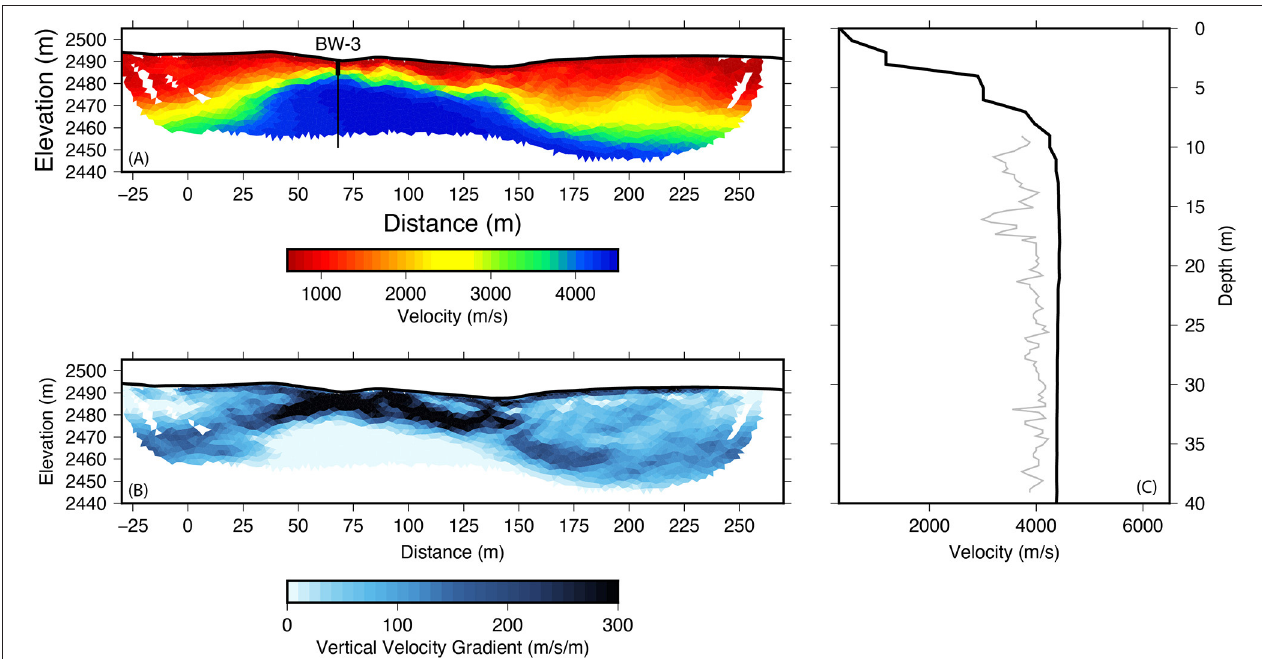
FIGURE 7 | Travel-time tomography results for L25. (A) Final P-wave velocity model estimated by travel-time tomography. Model fits and uncertainty are provided in the supplementary material ( Supplementary Figure S3 ). The models are masked by ray paths. The borehole location is show as vertical line where the thickest part of the line represents the casing. The profile intersected BW-3 at 68m. (B) Vertical gradient of velocity calculated at each pixel in the model. Dark colors indicate a sharp increase in velocity vertically and highlight the location of the strong elastic boundary in the model. (C) Comparing the refraction and sonic velocities. In this plot everything has been converted into the depth domain using the topography from the LiDAR ( Figure 1 ). The thin colored gray line is the sonic velocity profile from the borehole log. The thick black line is the extracted vertical velocity profile from panel “a” and the thin gray line is the sonic velocity profile from